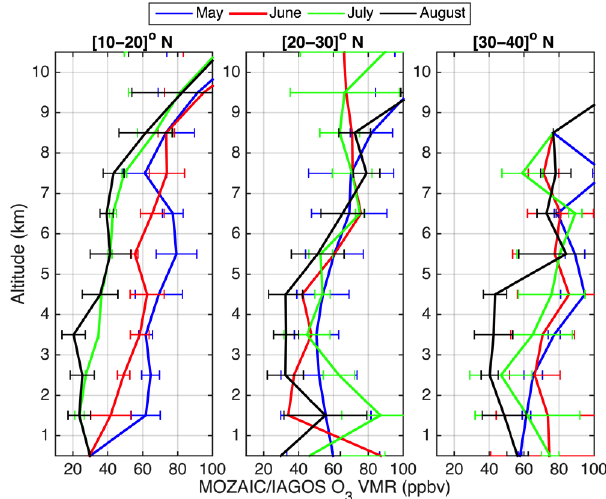
Figure 6. Monthly averaged vertical profiles of tropospheric O 3 from MOZAIC during the period May–August 2011 at 10–20, 20– 30 and 30–40 ◦ N. Error bars correspond to the standard deviation.